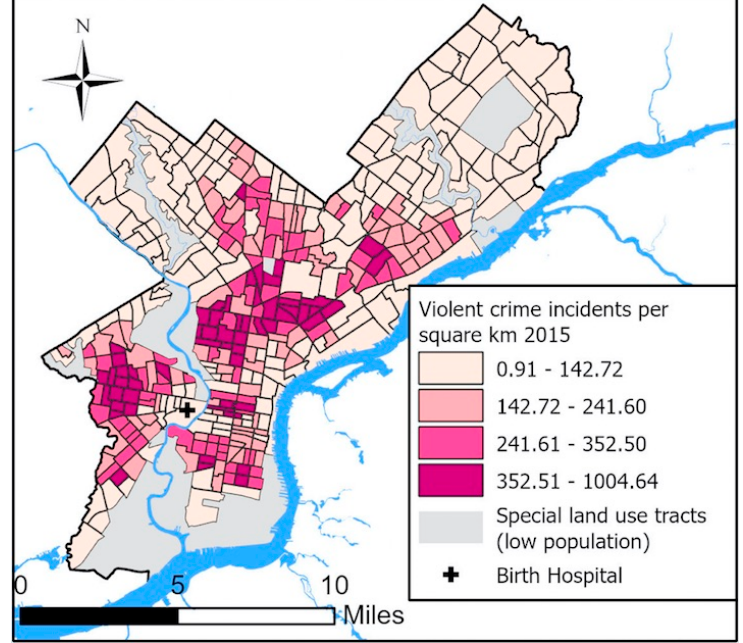
Figure 2. Neighborhood violent crime across Philadelphia, 2015.